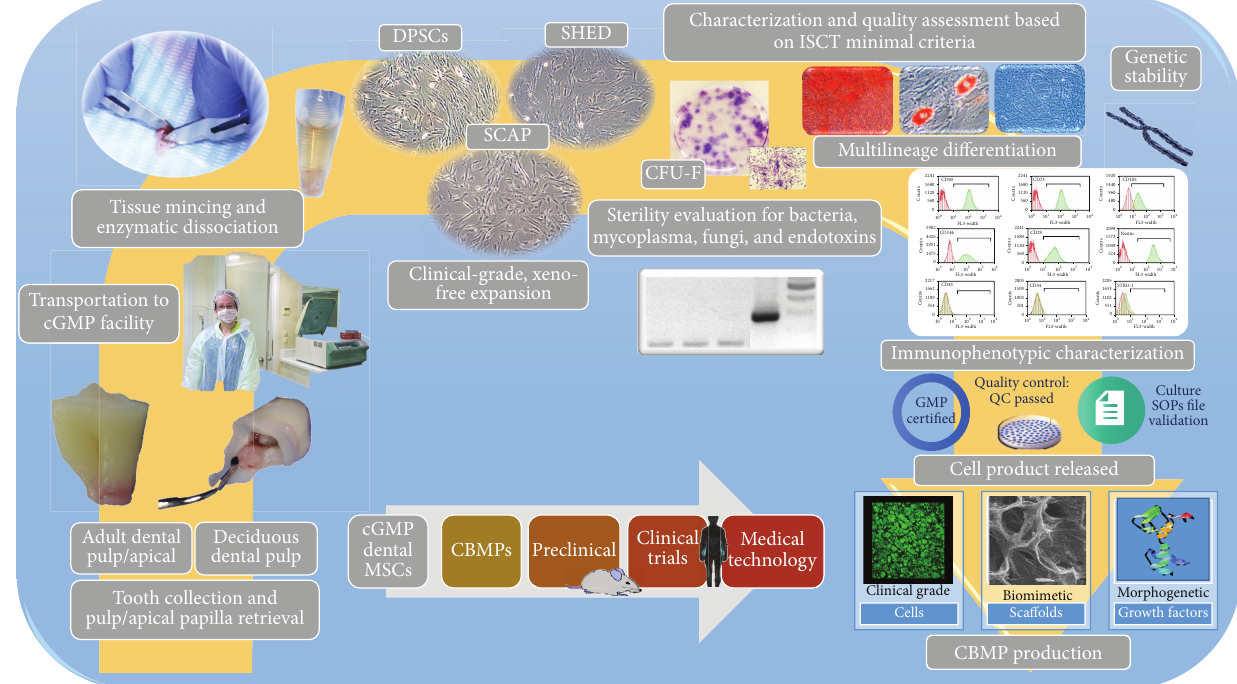
Figure 1: Process for the development of clinical-grade, xeno-free, GMP-compliant dental MSC cultures and of the respective dental MSC- based CBPMs for preclinical and clinical